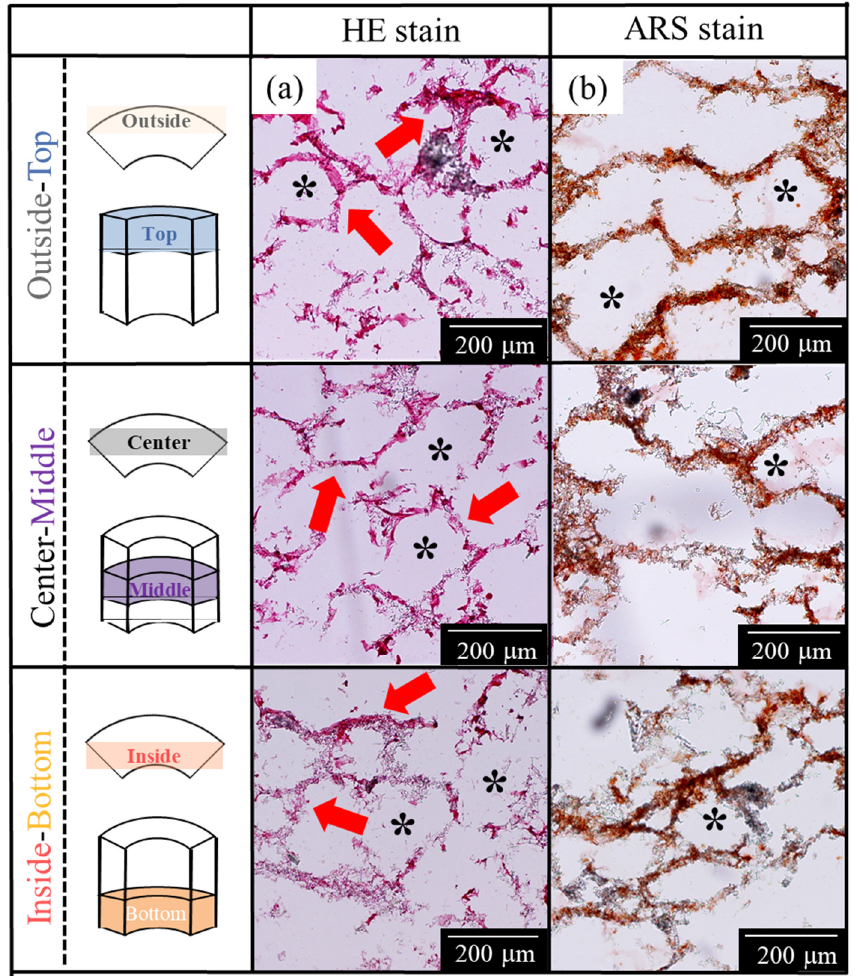
Figure 3. Histological evaluation using HE and ARS staining for the “1w-1w”. ( a ) HE staining and ( b ) ARS staining. Red arrows: Cells located along the AFS skeletons; *: AFS macropores.